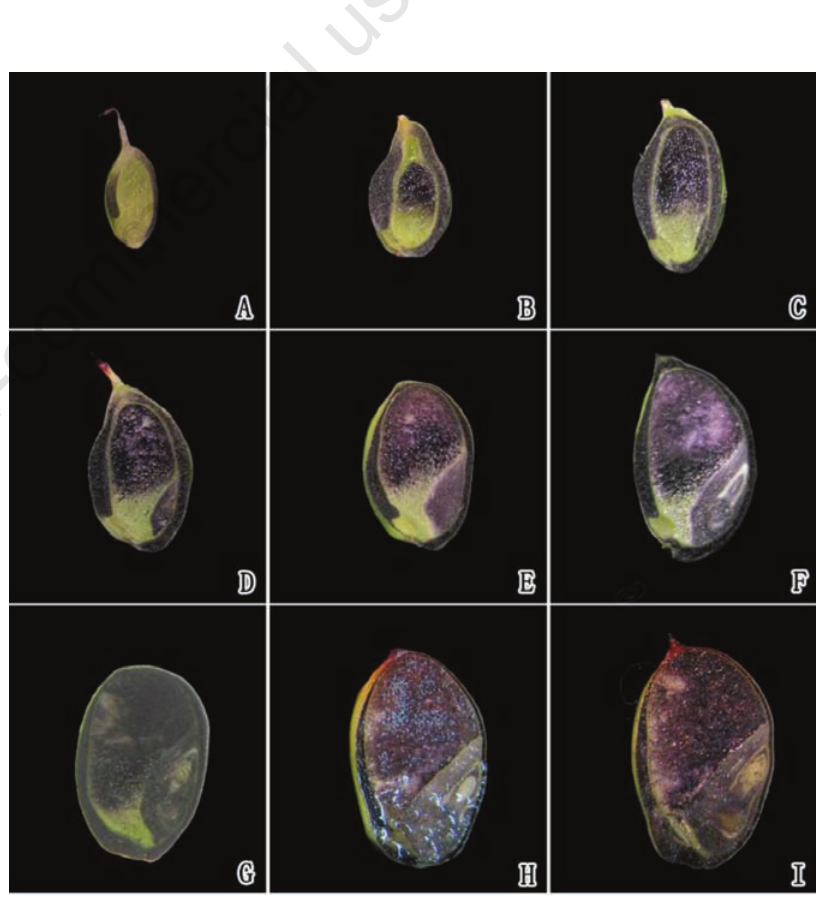
Figure 4. Sorghum endosperm at different days after pollination (DAP) under the stereo - microscope. A, 3 DAP; B, 6 DAP; C, 9 DAP; D, 12 DAP; E, 15 DAP; F, 18 DAP; G, 21 DAP; H, 24 DAP; I, 27